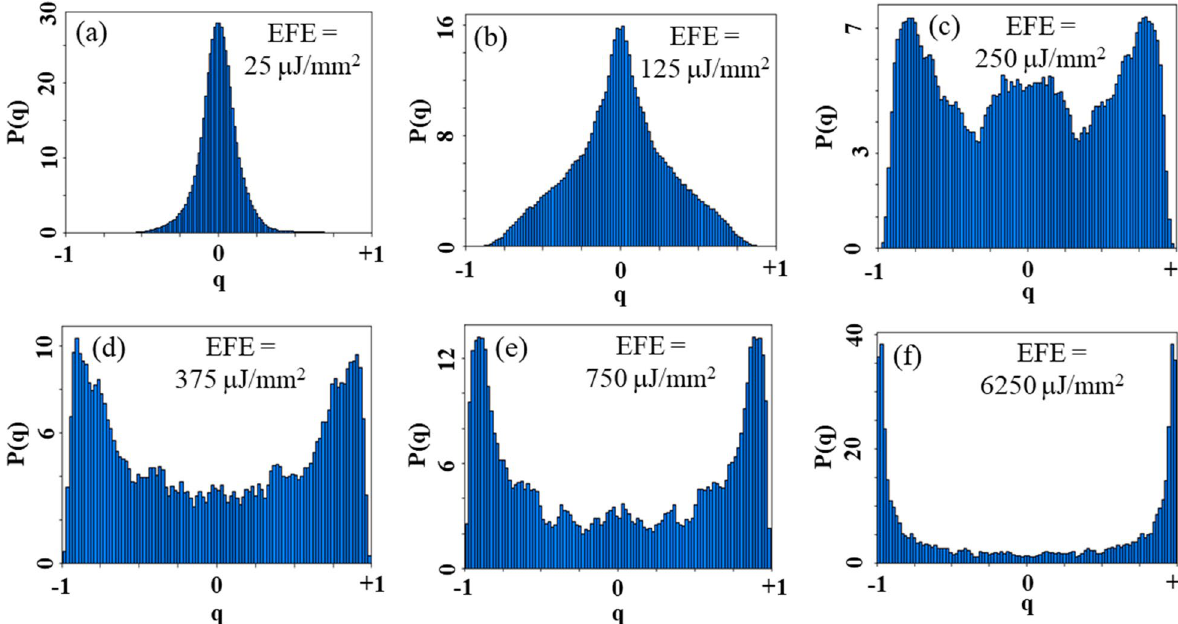
Figure 8. Probability distribution of the Parisi overlap parameter for different EFEs. Below threshold: ( a ) EFE = 25 μJ/mm 2 , and ( b ) EFE = 125 μJ/mm 2 . In both cases the maximum of P(q) occurs at q max ≈ 0. ( c ) On the threshold: EFE = 250 μJ/mm 2 ; the maximum of P(q) occurs at EFE = 375 μJ/mm 2 , ( e ) EFE = 750 μJ/mm 2 and ( f ) EFE = 6250 μJ/mm 2 ; the maximum of P(q) consolidates at ∼= 1 q max (cid:31) (cid:31) (cid:31) (cid:31)